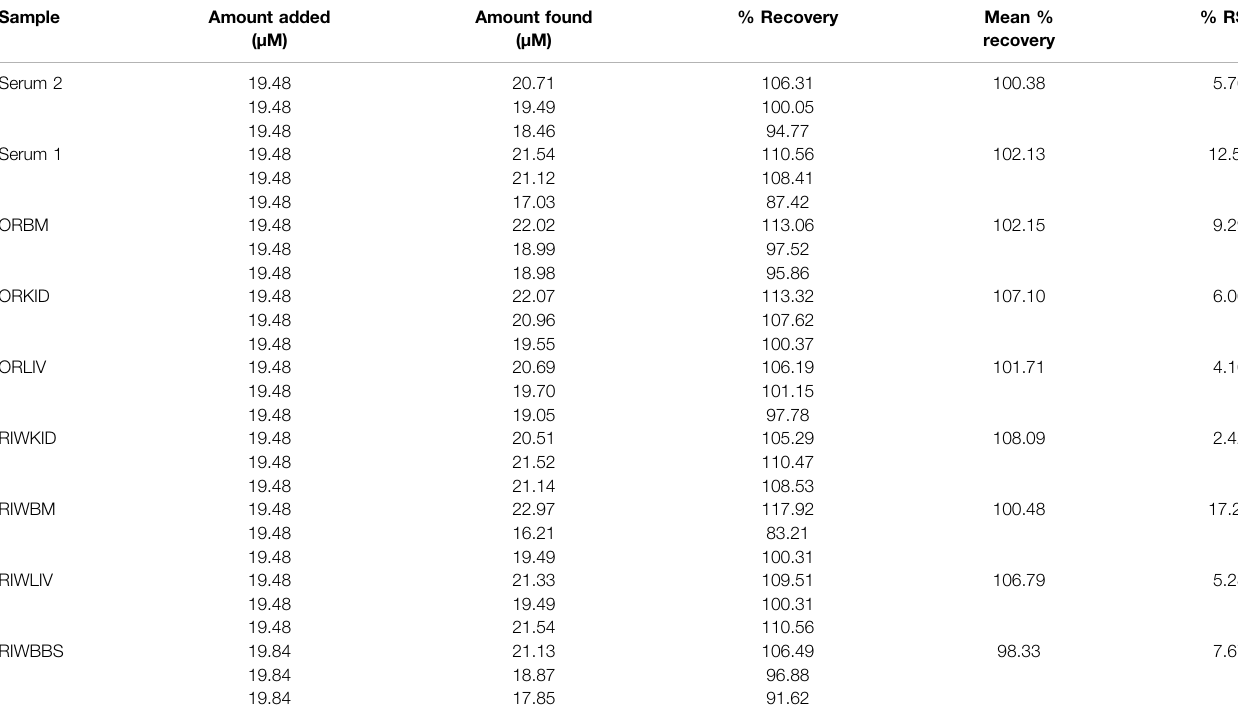
TABLE 3 | Real sample analysis data ( n = 3).